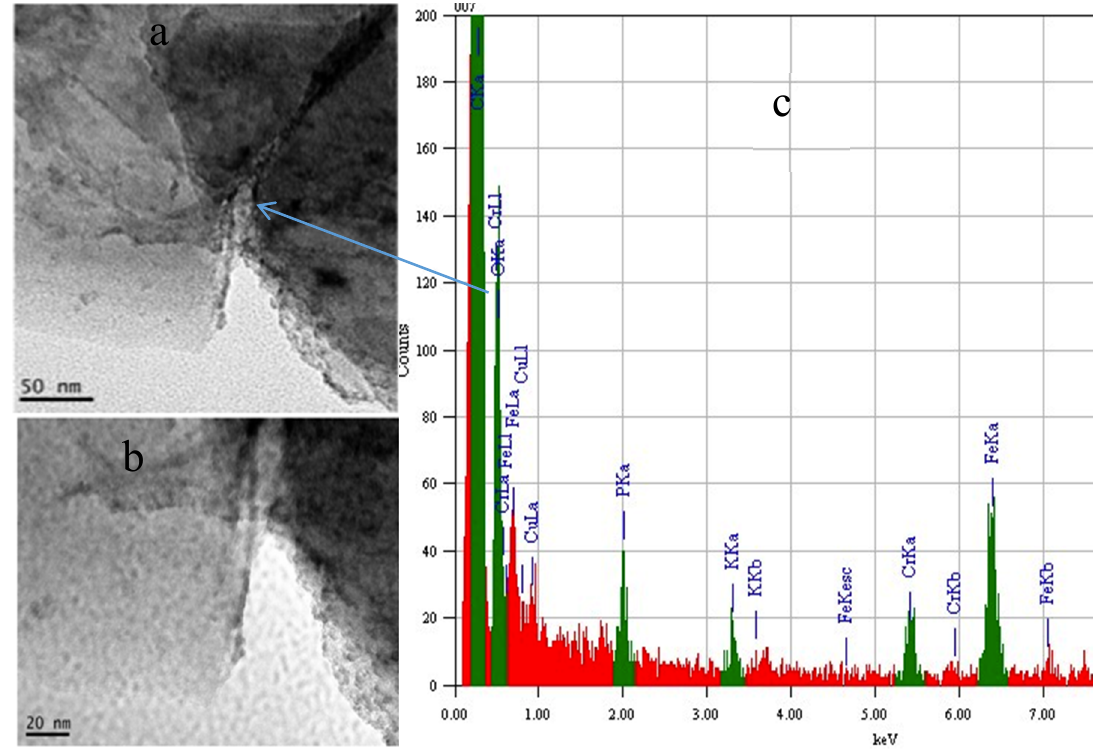
Figure 4. ( a ) TEM image of the oxidized surface of the Saligna biochar where the light coloured region is amorphous carbon and the darker areas are Fe-rich minerals; ( b ) is a magnified TEM image of the crack arrowed in Figure 5a,c; ( c ) is an EDS spectrum taken from the area around the